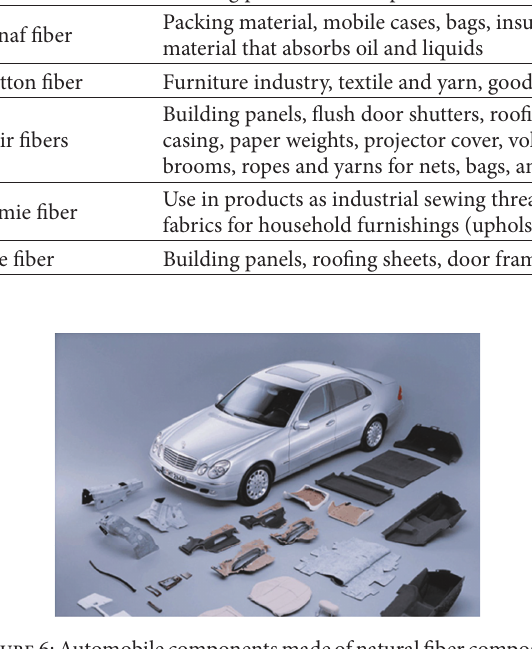
cellulose fiber to make Seatback, door panel, boot-lid finish panel, boot-liner in Passat Variant, Golf, A4, and Bora